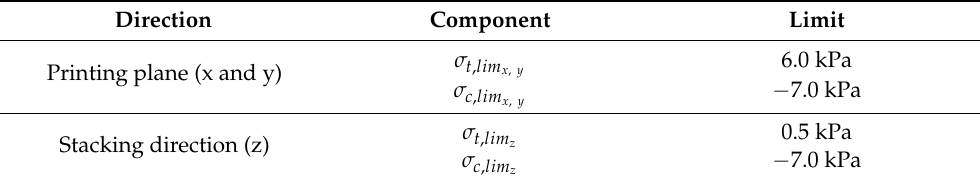
Table 2. Maximum stress limits for debinding simulation according to [20]. The tensile stress limit is abbreviated with σ t , lim and the compression stress limit with σ c , lim i